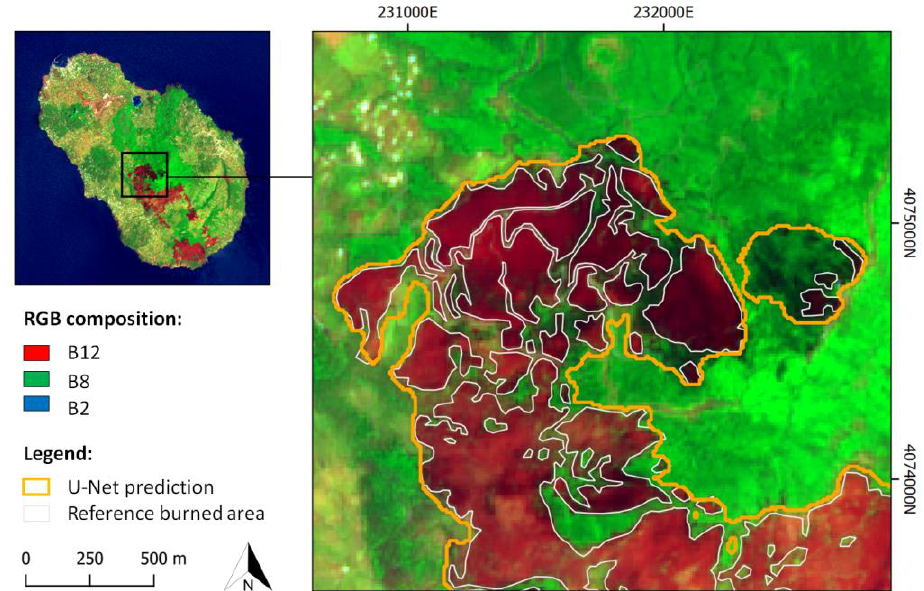
Figure 11. U-Net prediction and reference burned area highlighting details within a burned area in study area A. The background image is a composition of the B12, B8 and B2 spectral bands and burned areas appear in red.